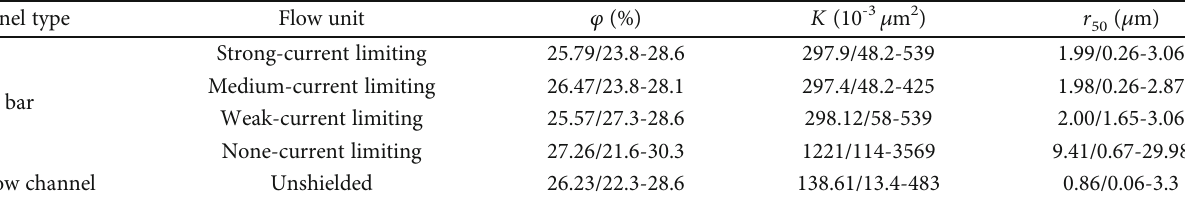
Table 7: Geological parameters of di ff erent fl ow units.